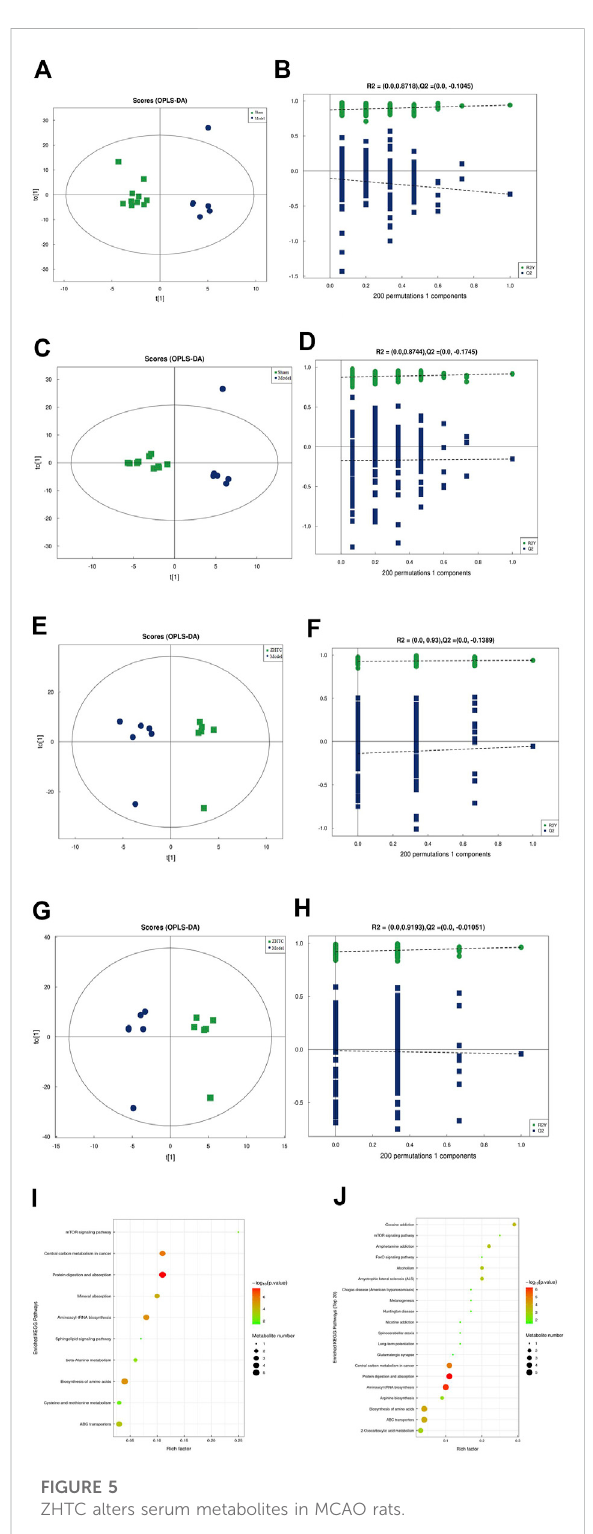
FIGURE 5 ZHTC alters serum metabolites in MCAO